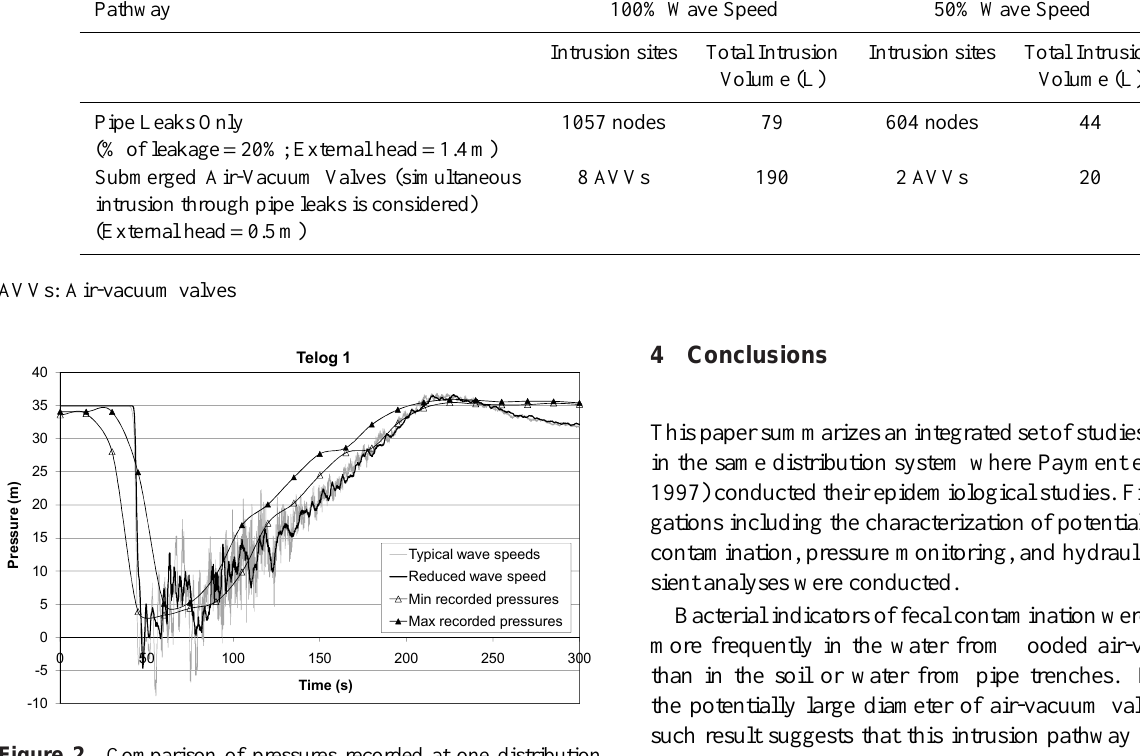
Figure 2. Comparison of pressures recorded at one distribution system site with pressures modelled with typical wave speeds and with a reduced wave velocity in cast-iron pipes (four pressure values per second were measured by the pressure recorders but only the minimum and maximum pressures over 15s intervals were saved ( 4 and N